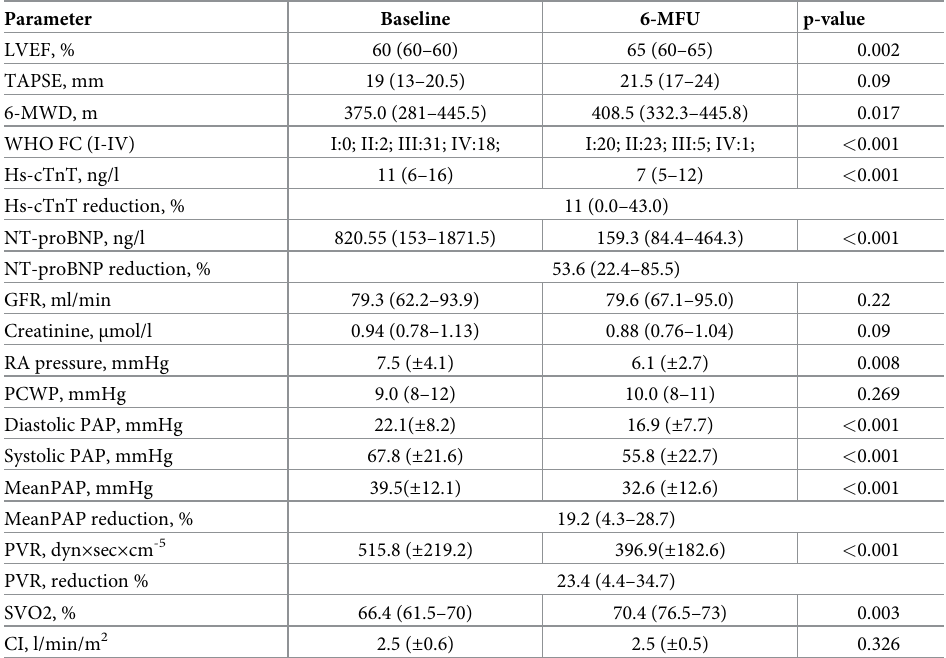
Table 2. Functional, biomarker, echocardiographic, and hemodynamic data at BL and 6-MFU.